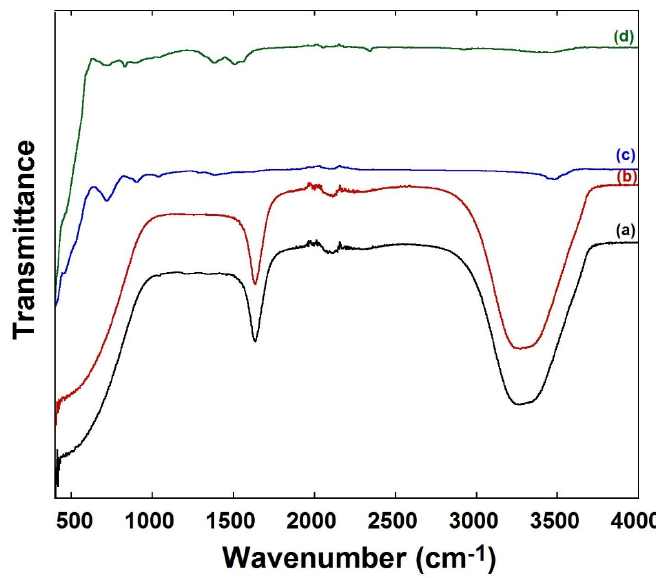
Figure 2. The FTIR spectra of ( a ) Acacia extract. ( b ) Sample ZC50 after precipitation. ( c ) Sample ZC50 after hydrothermal treatment and drying. ( d ) Sample ZC50 after calcination. Figure 3 represents the XRD patterns of the samples ZC0, ZC25, ZC50, ZC75, and ZC100 prepared by the green-hydrothermal technique (pH = 10, T = 250 ◦ C, t = 2.5 h) and calcined at 300 °C for 2 h. The ZC0 sample shows peaks at 2 θ ~31.96°, 34.61°, 36.44°, 47.74°, and 56.73° corresponding to the diffraction planes (1 0 0), (0 0 2), (1 0 1), (0 1 2), and (1 1 0)